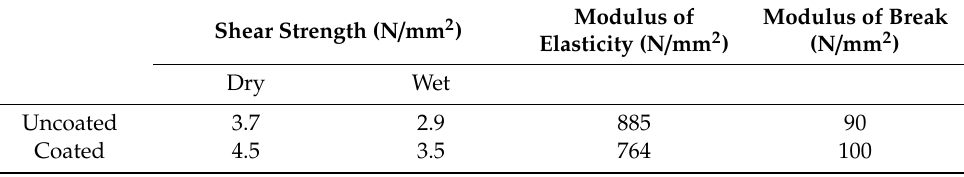
Table 9. Bending data [84].